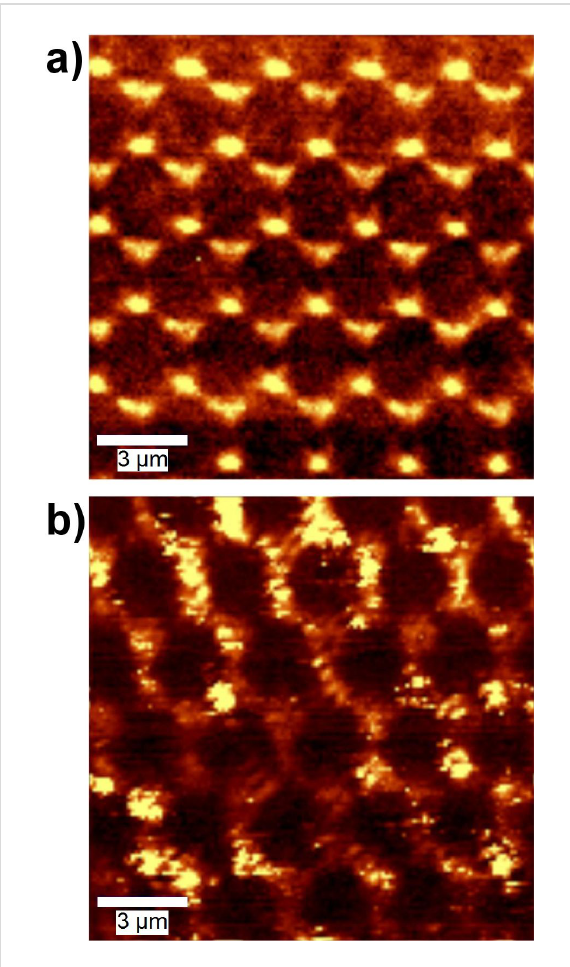
Figure 10: Confocal microscopy images of the Ag nano-antenna struc- tures (produced using 3 μ m diameter colloid spheres) covered with TiO 2 :Eu nanophosphors under illumination with 532 nm laser light. In (a) intensity in the wavelength region 530–535 nm has been used, whereas in (b) the region 605–630 nm is used. The scale bars mark a length of 3 μ